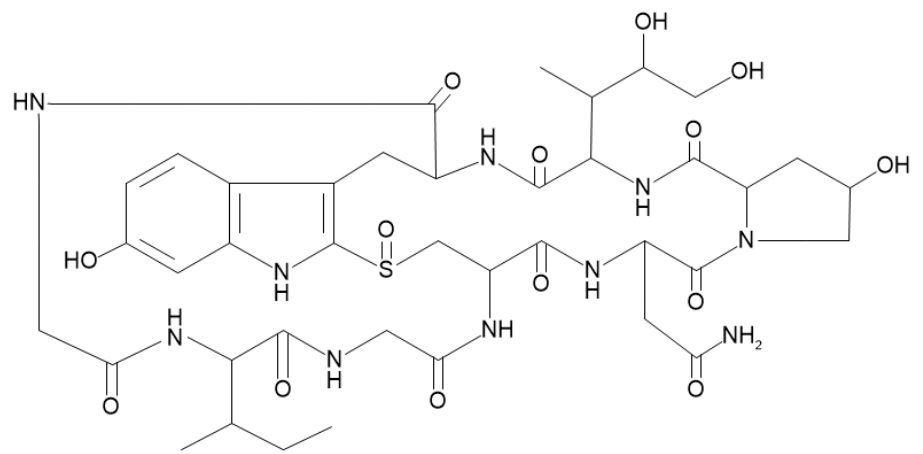
Figure 1. Structure of α‐ amanitin.